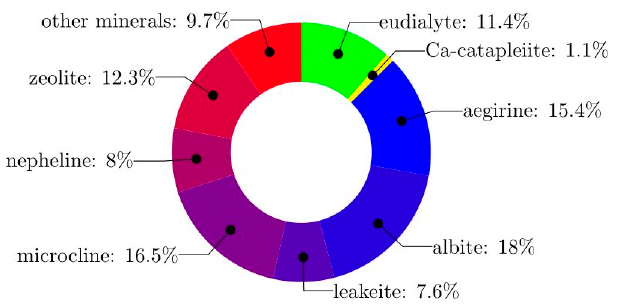
Figure 1. Mineral composition of the concentrate in wt % determined by mineral liberation analysis (MLA).